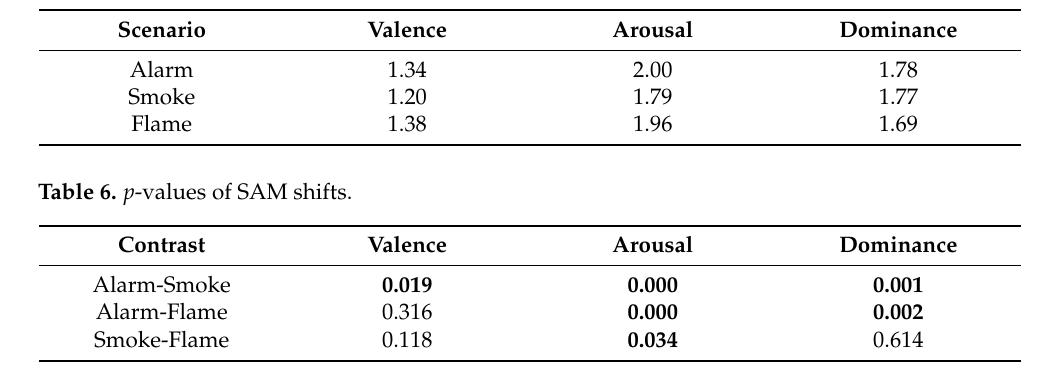
Table 5. Standard deviations of SAM shifts.